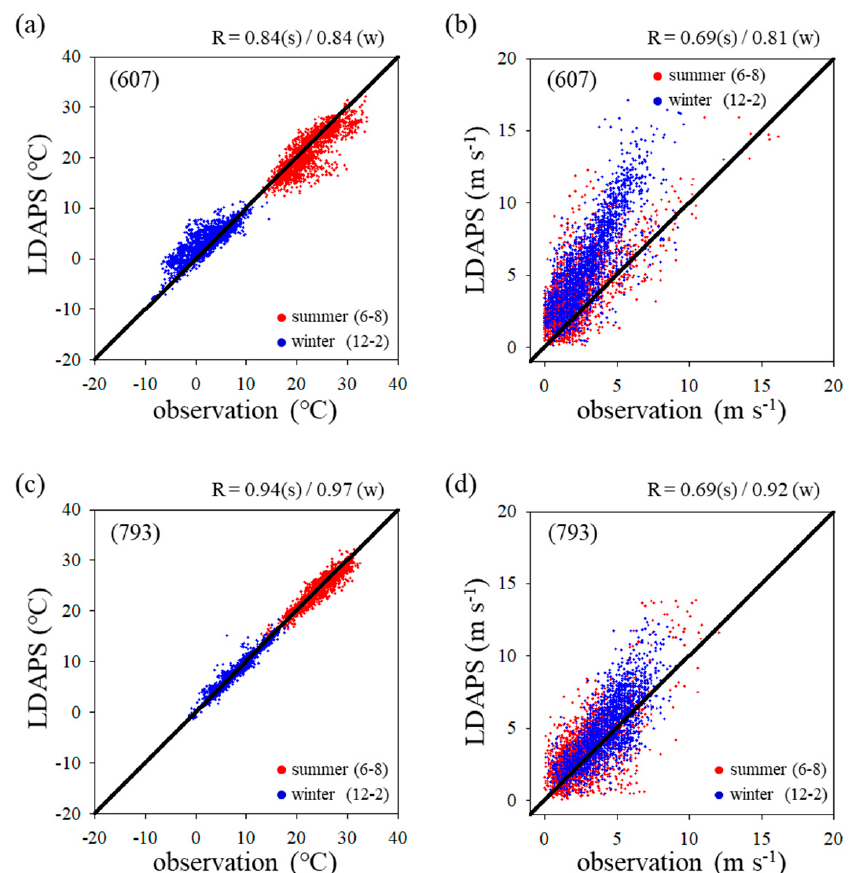
Figure 12. Scatter plots of the AWS-observed and LDAPS-predicted temperatures (left panels) and wind speeds (right panels) at the ( a , b ) AWS 607 (LDAPS grid located at sea) and ( c , d ) AWS 793 (LDAPS grid located at land). Red and blue dots indicate for summer season (June, July, and August) and winter season (December, January, and February), respectively.